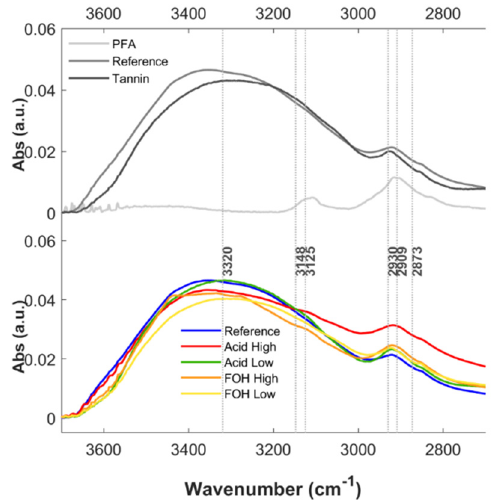
Figure A1. FTIR spectra of PFA, mimosa tannin extract and tannin-furanic foam (five formulations) in the 2600–3800·cm − 1 spectral region. Upper panel: Average absorbance spectra of Reference foam (dark-grey), PFA (medium-grey) and mimosa tannin extract (light-grey). Bottom panel: Average absorbance spectra of Reference foam (blue), Acid high (red), Acid low (green), FOH high (orange) and FOH low (yellow) treatments in the 2800–3500·cm − 1 region.